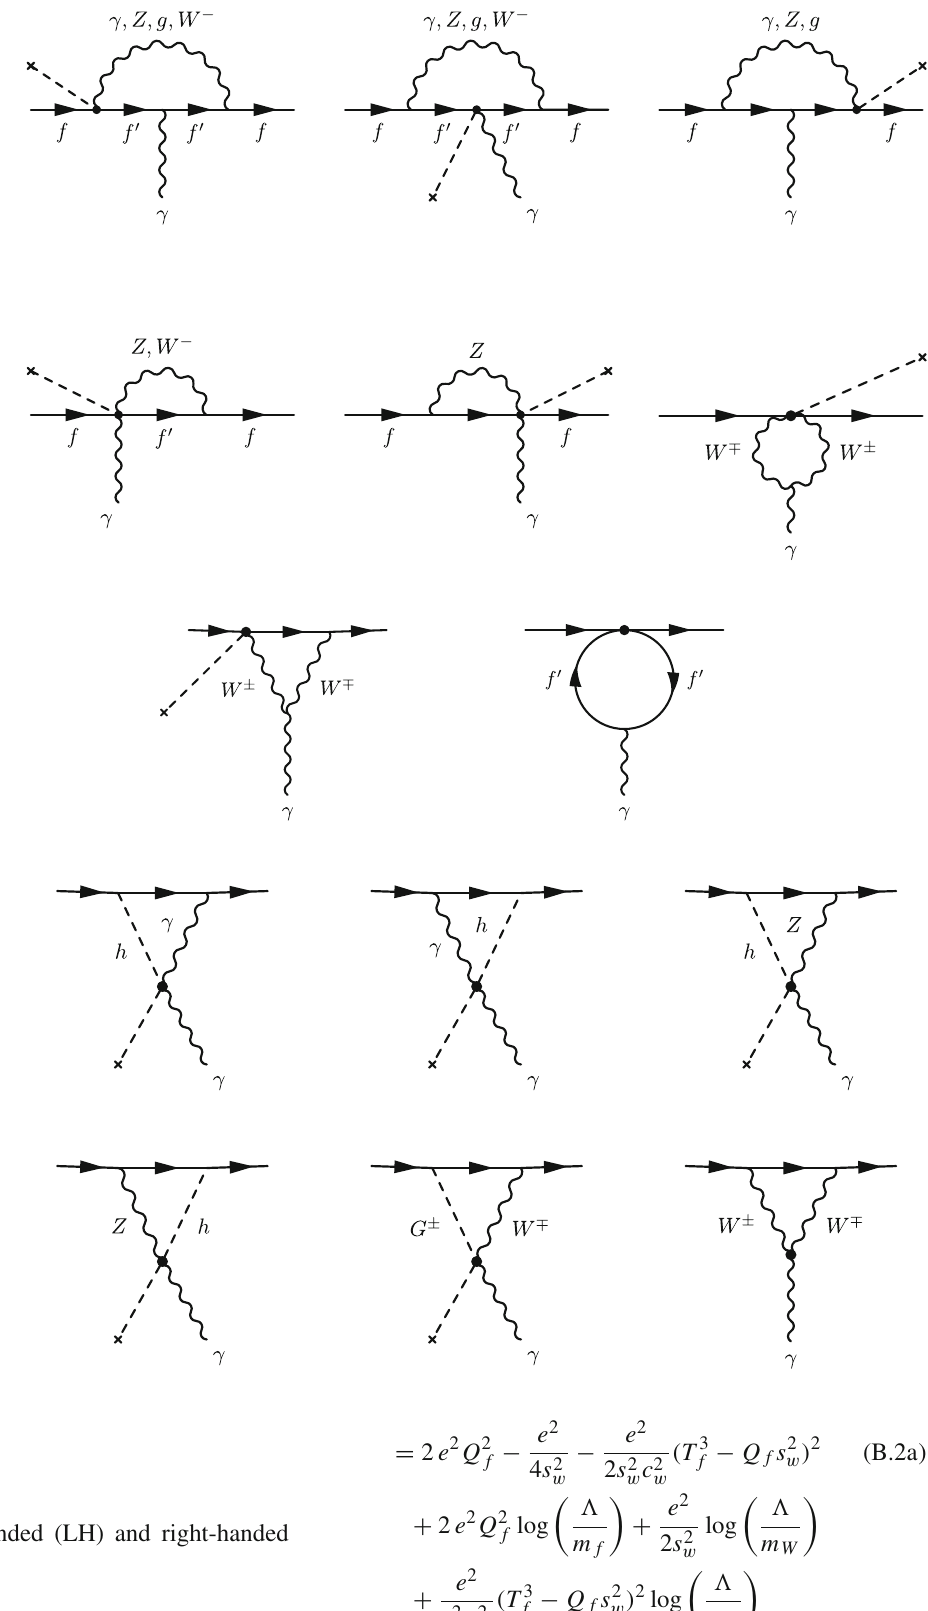
Fig. 13 1PI diagrams contributing to the ¯ ψψγ 3-point function. Notice that the diagram with the lepton loop exists only for external up-type quarks and